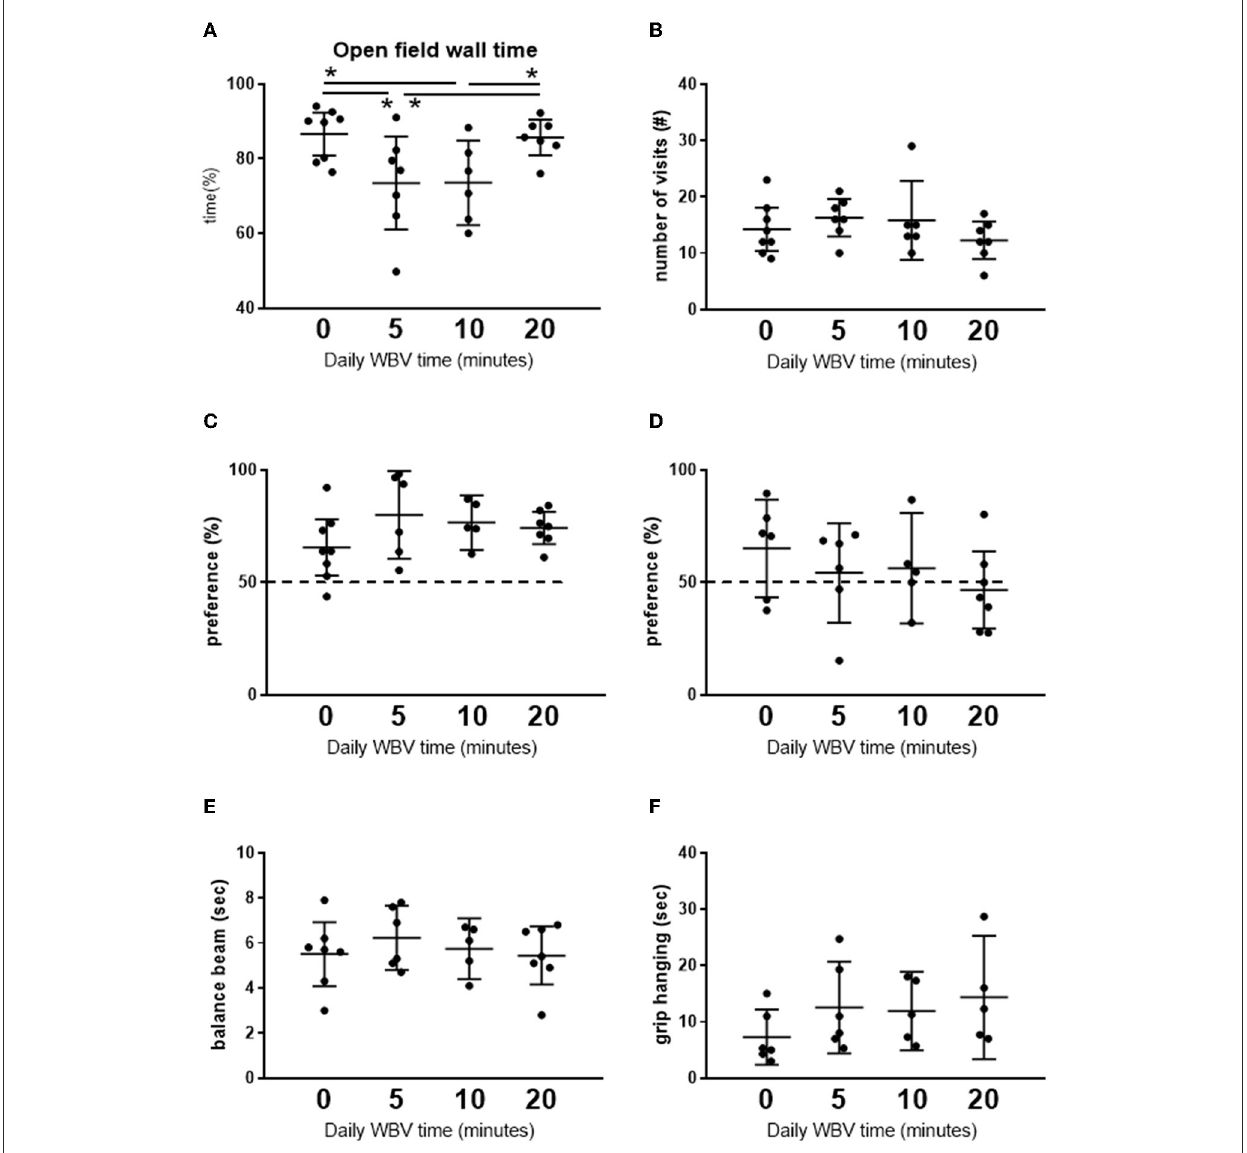
FIGURE2 (A, B) Results from the open field test. (C, D) Short-term memory in the NOR and NLR test, respectively. (E, F) Effects on motor function. Results from the pilot exposure time-effect study on the different whole-body vibration (WBV) session times ( n = 5–8 per group). Rats were subjected to 5 weeks daily (5 days a week) WBV for 0 (pseudo), 5, 10, or 20min. Behavioral responses were obtained according to descriptions in the methods section. *Significant effect ( p <